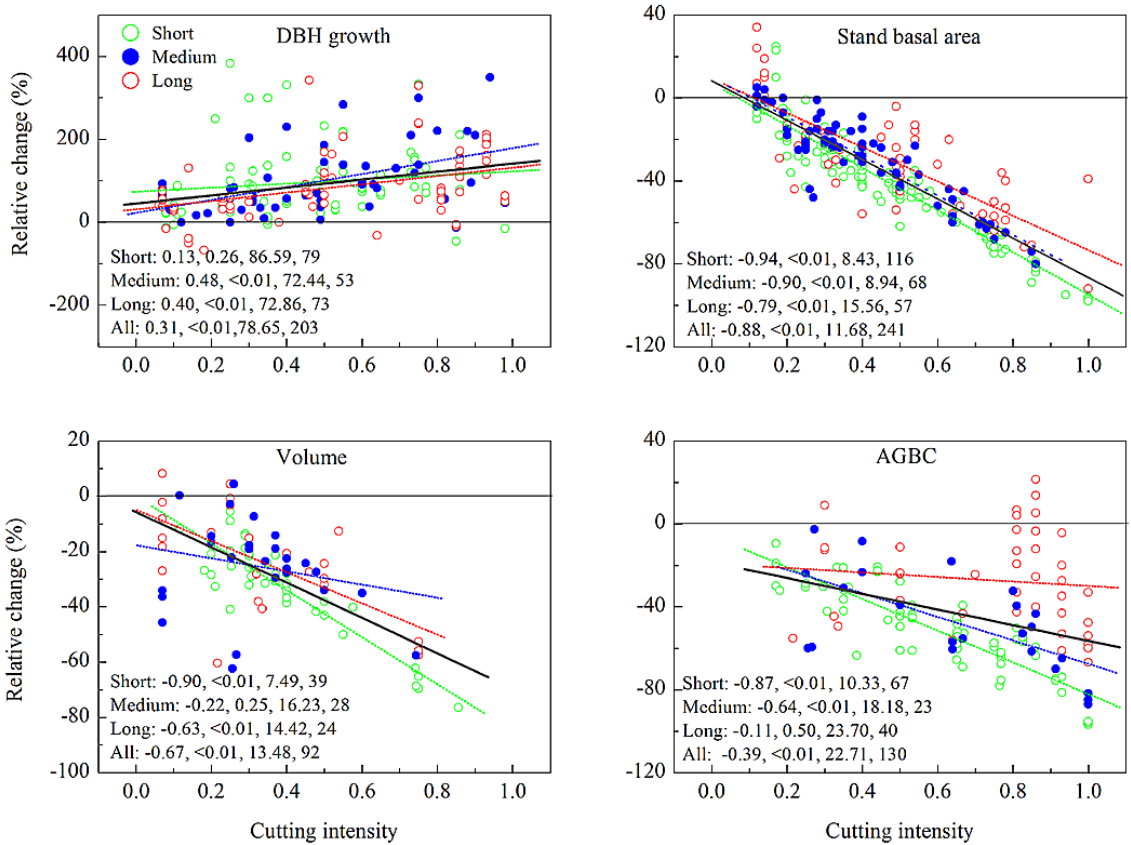
Fig. 4. The relative changes (%) along the CI gradient where the observations were grouped by the recovery years (RY) since cutting activities into short (green circle: RY ≤ 5yr), medium (blue circle: 5yr < RY ≤ 10yr), and long (red circle: RY > 10yr) time periods. The dotted lines represent the linear fit curves of short, medium, and long RY with corresponding colors, and the bold black line indicates the linear fit curve of all observations. The correlation coefficient ( R ), confidence of significance ( P ), standard error (SE), and the number of observations ( N ) of each linear regression analysis are shown at the bottom of figure panel. Five observations that are larger than 400% were not shown in the figure panel of DBH